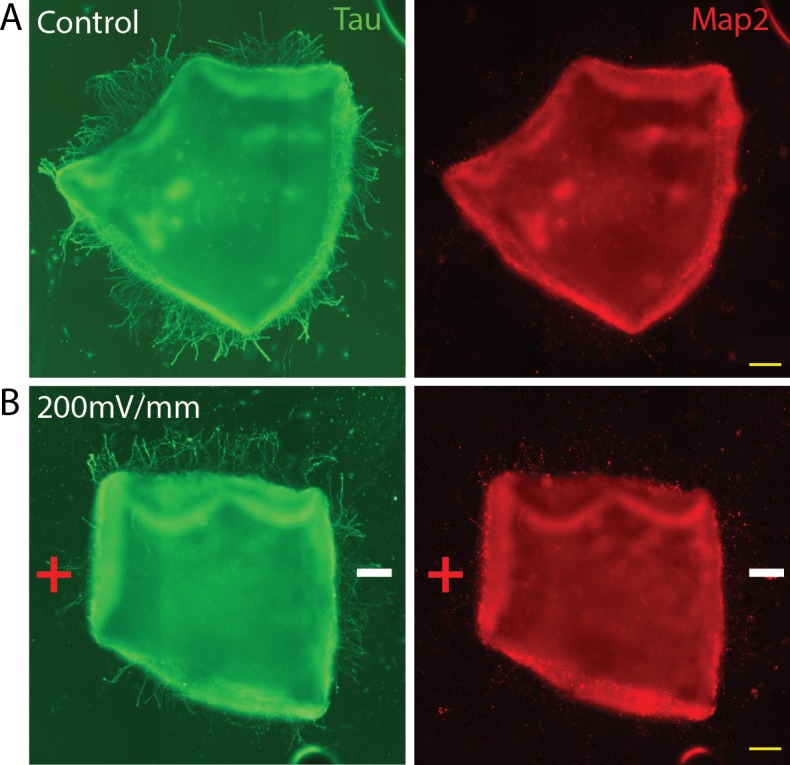
Retinal neurites are axons that demonstrate Tau immunopositivity. Retinal explants were grown for 18 hours, then exposed to an EF of 200 mV/mm for 4 hours. Staining of control (A) and EF-treated (B) explants with anti-Tau and MAP2 antibodies demonstrated that EF-responsive neurites positively stain with axonal (Tau) but not dendritic (MAP2) markers. Scale bar: 100 μm.